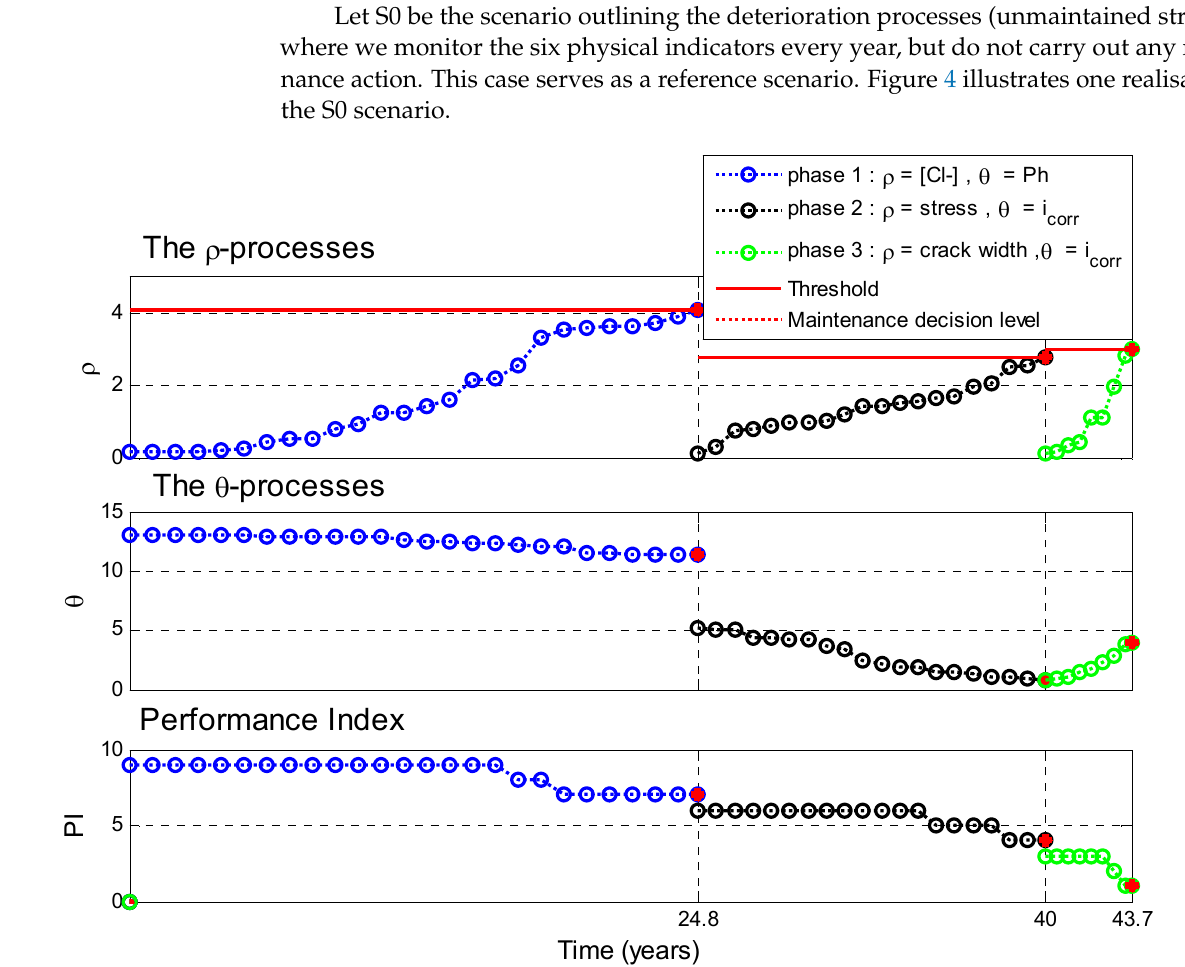
plot represents the 𝜌 indicators per phase (chloride content, as well as stress and crack width) and controls the transition between the phases (red line); (2) the second plot shows the 𝜃 indicators per phase ( pH and corrosion current density); and (3) the bottom plot tracks the evolution of the performance index (here, the condition index is 𝐶𝐼 ) in time. The 𝜌 indicators show that corrosion starts at 24.8 years, concrete cracking starts at 40 years, and the threshold crack is reached at 43.7 years. It is obvious that if any maintenance action is performed, then the performance index will decrease with time. 5.2. Single-Action Maintenance Policies 5.2.1. Preventive Maintenance Policy The Preventive Maintenance ( PM ) policy aims to prevent the steel initiation of corro- sion by applying a [ 𝐶𝑅 1] before the transition into the second phase ( 𝐶𝐼 = 7 ). This results in conserving the steel and keeping it intact. The inter-inspection period is set at 5 years [4,42,62] and we inspect the steel for the indicators of the actual period (e.g., if it is esti- mated we are in the first phase, then the inspections are carried out for [ 𝐶𝑙 (cid:2879) ] and pH ). We discuss the possibility of missing an inspection in the 𝐶𝐼 = 7 range for this pol- icy. Consequently, this results in not triggering [ 𝐶𝑅 1]. This is due to two reasons: (a) the inter-inspection time is long, and (b) the size of the class 𝐶𝐼 = 7 is narrow. In this case, inspections for the second phase are required ( 𝜌 (cid:2870) and 𝜃 (cid:2870) ) in order to assess the extent of damage, i.e., to make sure that the corrosion has started. Furthermore, a [ 𝐶𝑅 2] is required